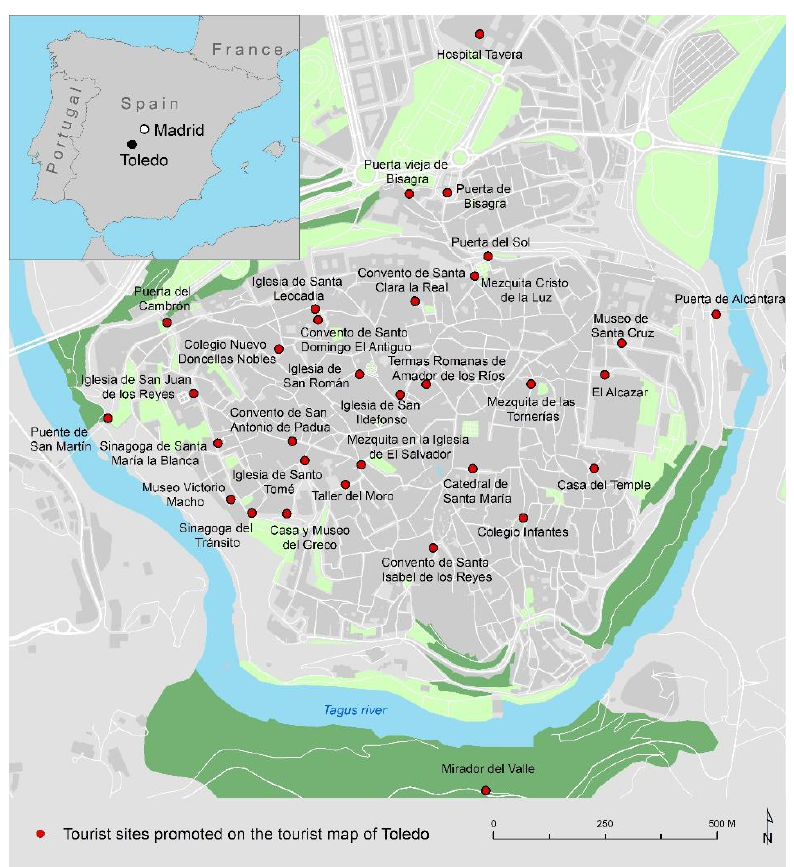
Figure 1. Location of the tourist sites promoted on the official tourist map of the historic centre of Toledo. Source: Authors’ own elaboration. ISPRS Int. J. Geo-Inf. 2020 , 9 , x FOR PEER REVIEW